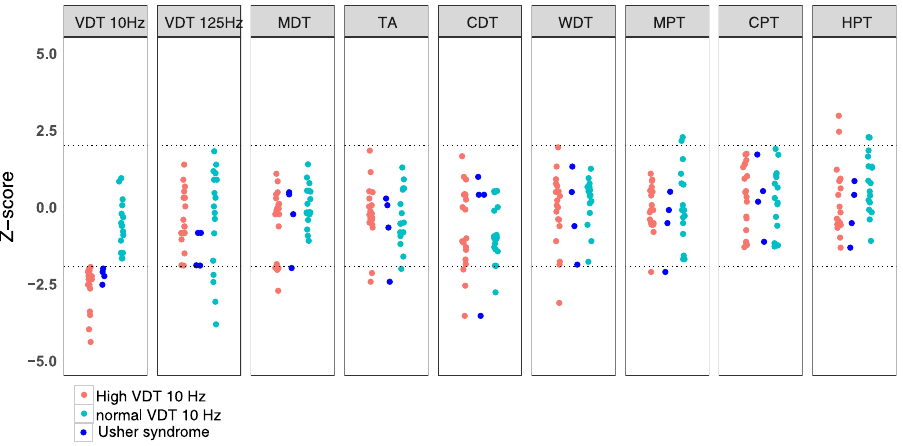
Figure 3. Dot plot of the z-score parameters in the congenitally deaf cohort. In red are deaf subjects with z-scores for VDTs at 10 Hz lower than − 1.96. Blue represent the rest of the group. Participants with hearing impairment who had high threshold in VDT 10 Hz did not consistently have increased thresholds in other